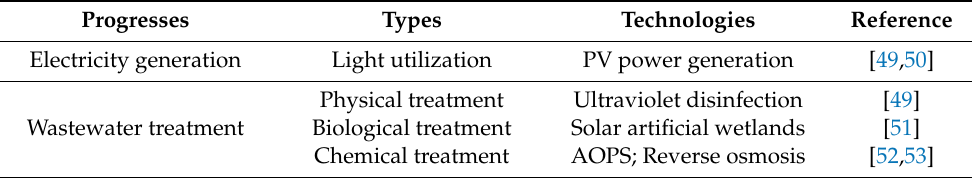
Table 2. Applications of solar energy in wastewater treatment plants